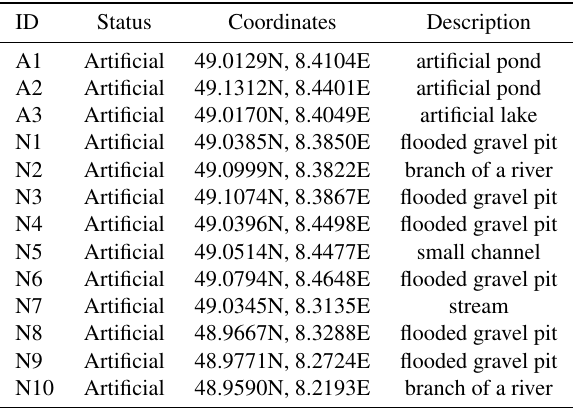
Table 1. Description of the investigated water bodies.